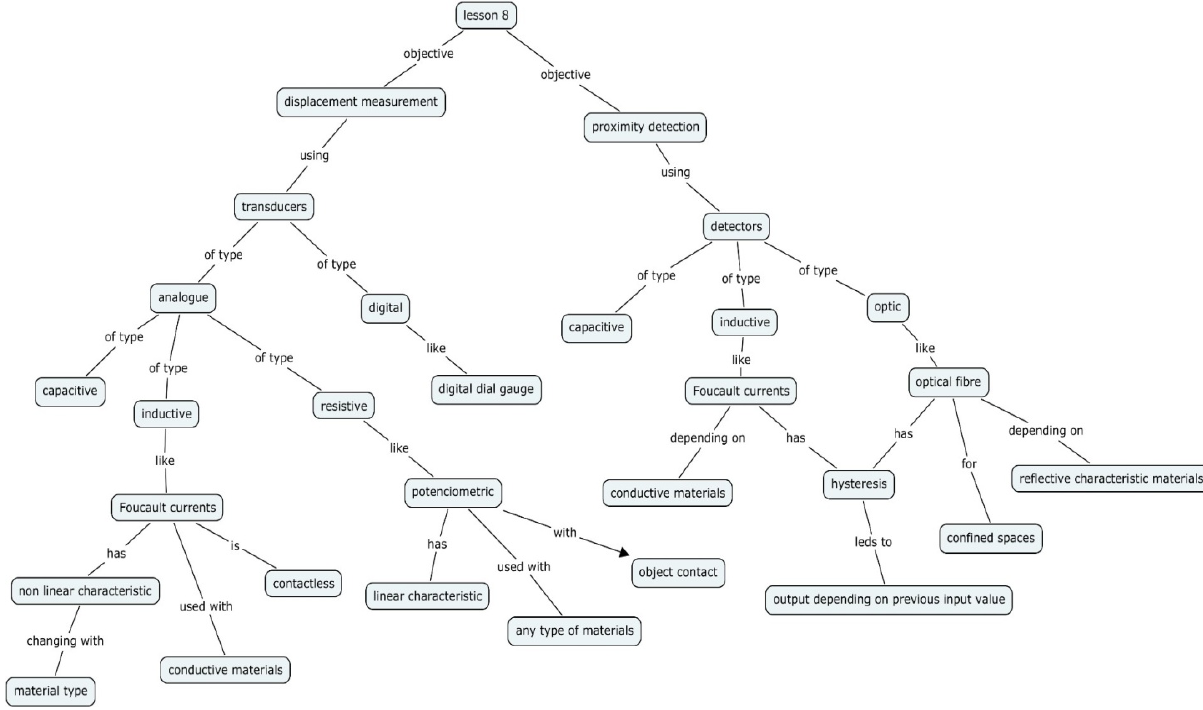
Figure 3. Student-Created Concept Map